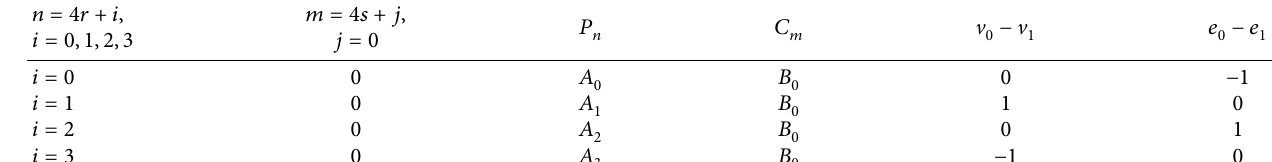
Table 2: Combinations of labeling.